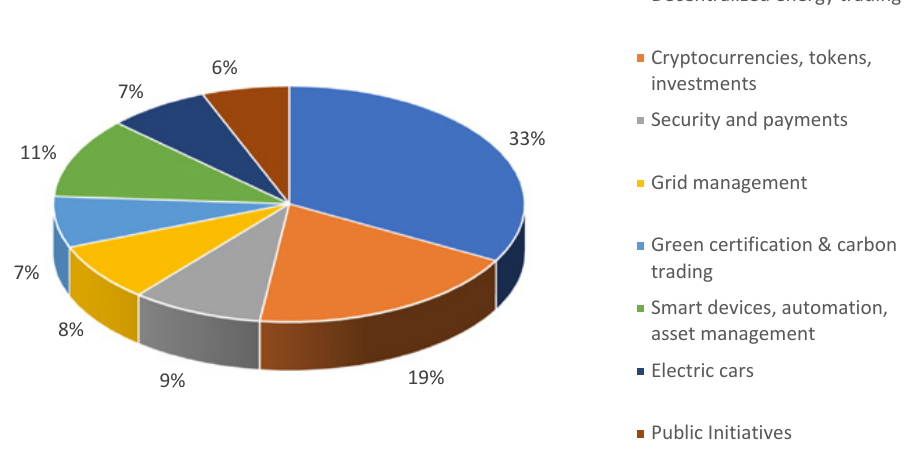
Fig. 6: Scenarios of blockchain use in energy sector projects